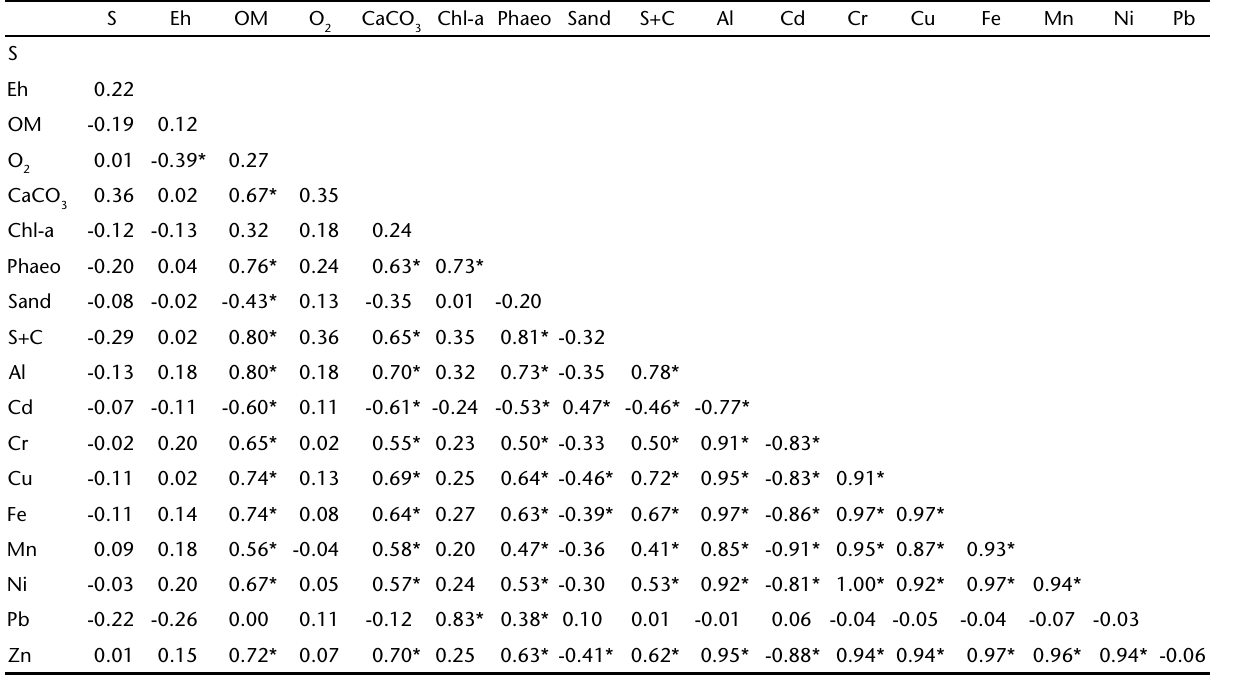
Table III. Correlation matrix among environmental and geochemical data.